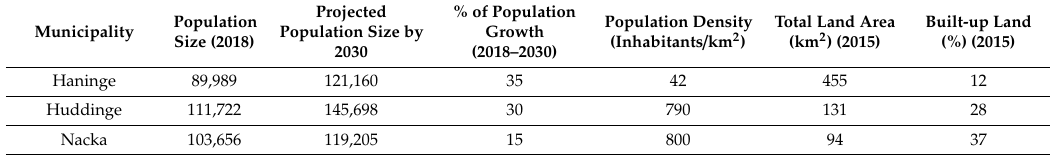
Figure 1. Map of Sweden, zoomed to Stockholm County and municipalities comprised in the study. Table 1. Overview of municipality statistics (Source: Region Stockholm, 2019; SCB,